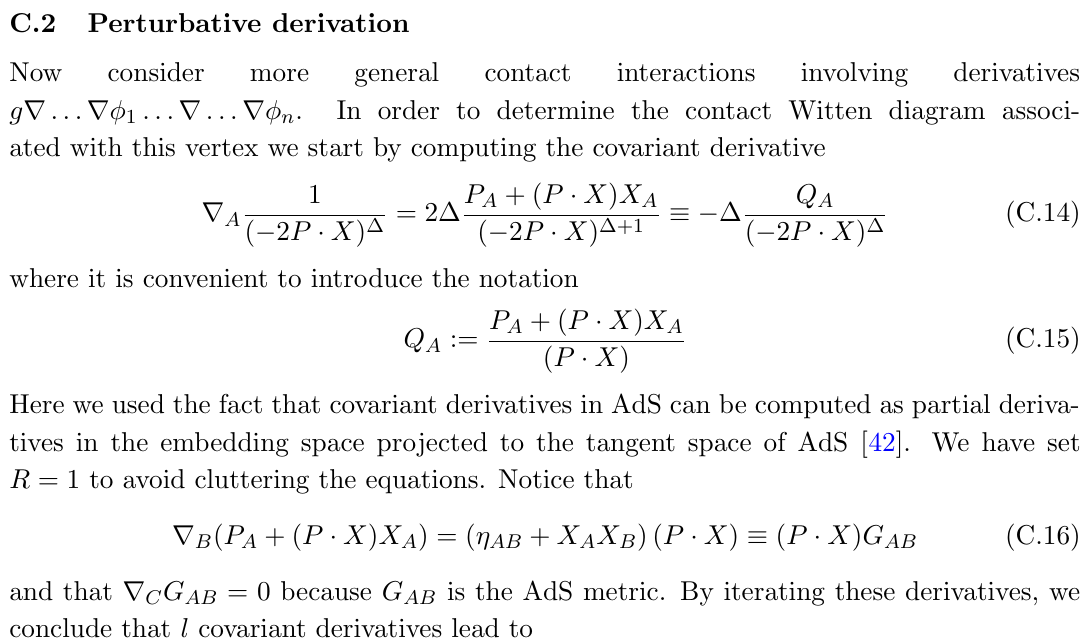
Figure 13 . The left (cid:12)gure shows the position of the poles of the Mellin amplitude associated with a tree-level scalar exchange Witten diagram. The middle (cid:12)gure shows the scaling of the residues of these poles in the (cid:13)at space limit (cid:1) ! 1 . On the right, we show the resulting analytic structure for the scattering amplitude. The in(cid:12)nite sequence of poles of the Mellin amplitude gives rise to a single pole in the scattering